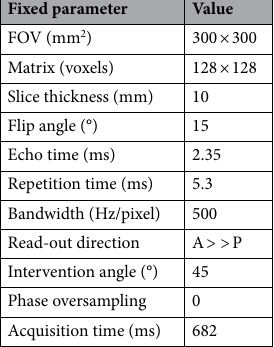
Table 3. Default settings. While one parameter was modified, all others remained unchanged in a predefined